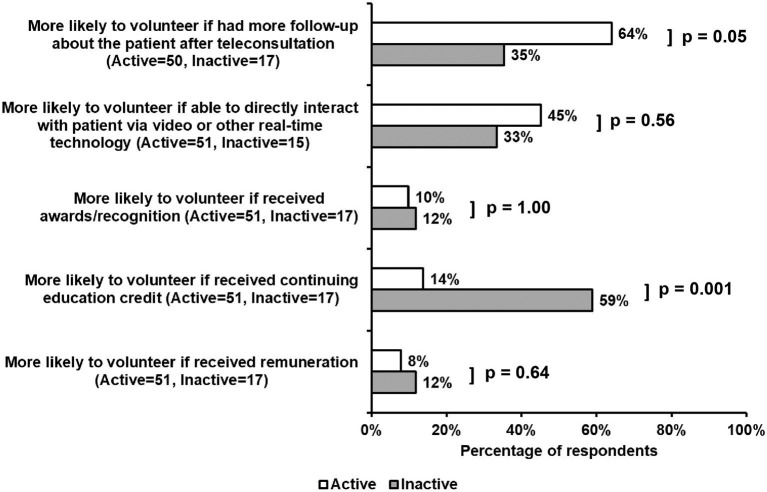
Survey responses regarding incentives for volunteer work. Increased patient follow-up significantly increased enthusiasm among active, as compared with inactive, volunteers (64 vs. 35%, p = 0.05). Additionally, the use of real-time technology was viewed as an incentive to volunteering for both active and inactive cohorts (45 and 33%, respectively). Alternatively, the opportunity to receive continuing education credit was a significant incentive for inactive volunteers, as compared with active respondents (59 vs. 14%, p = 0.001). Opportunities to receive remuneration or recognition did not increase the likelihood of volunteering for either cohort.